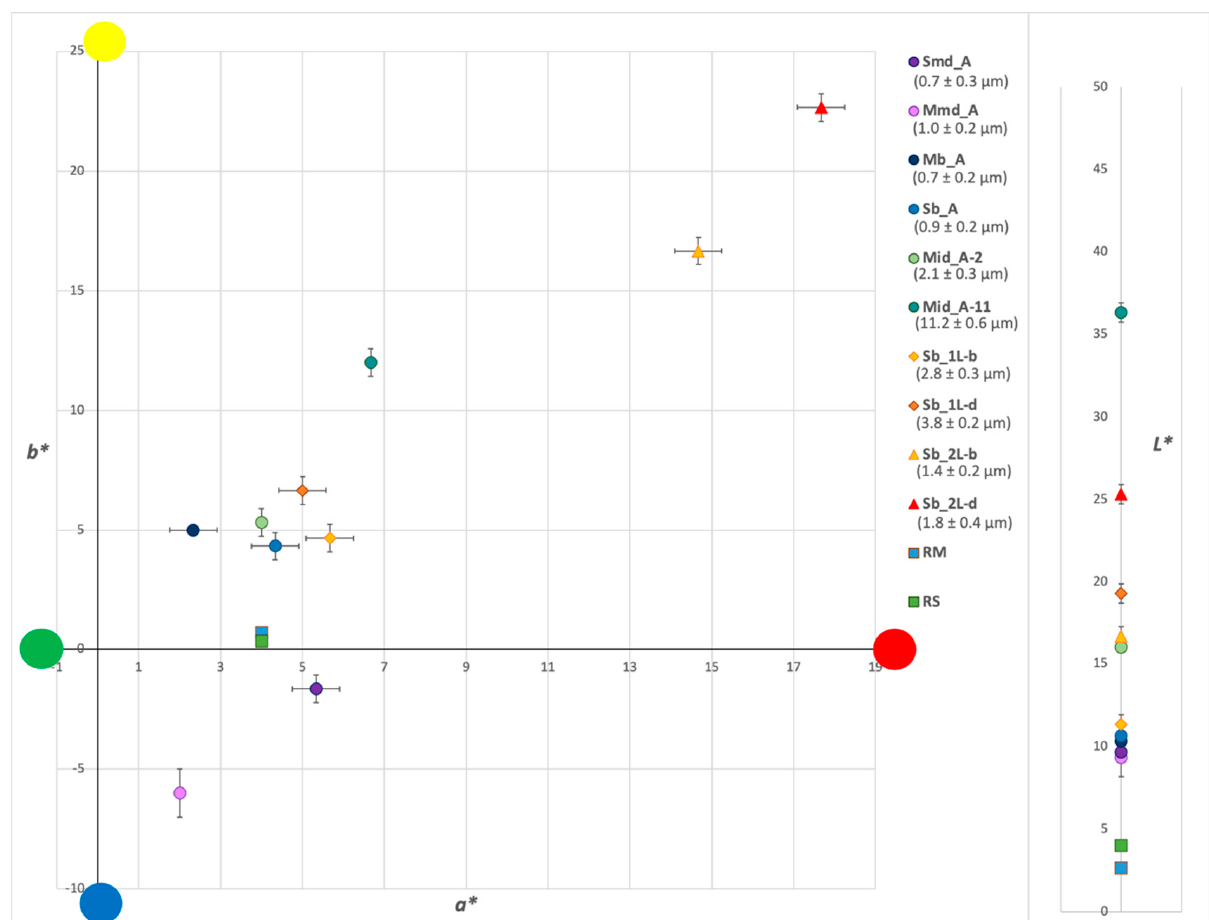
Figure 10. L * a * b * colorimetric coordinates of the fluorescence under UV light of coatings with different thickness (cf. Figure 3). ⬤ : varnish A; ◆ : varnish 1L; ▲ : varnish 2L; ■ : non-varnished references.